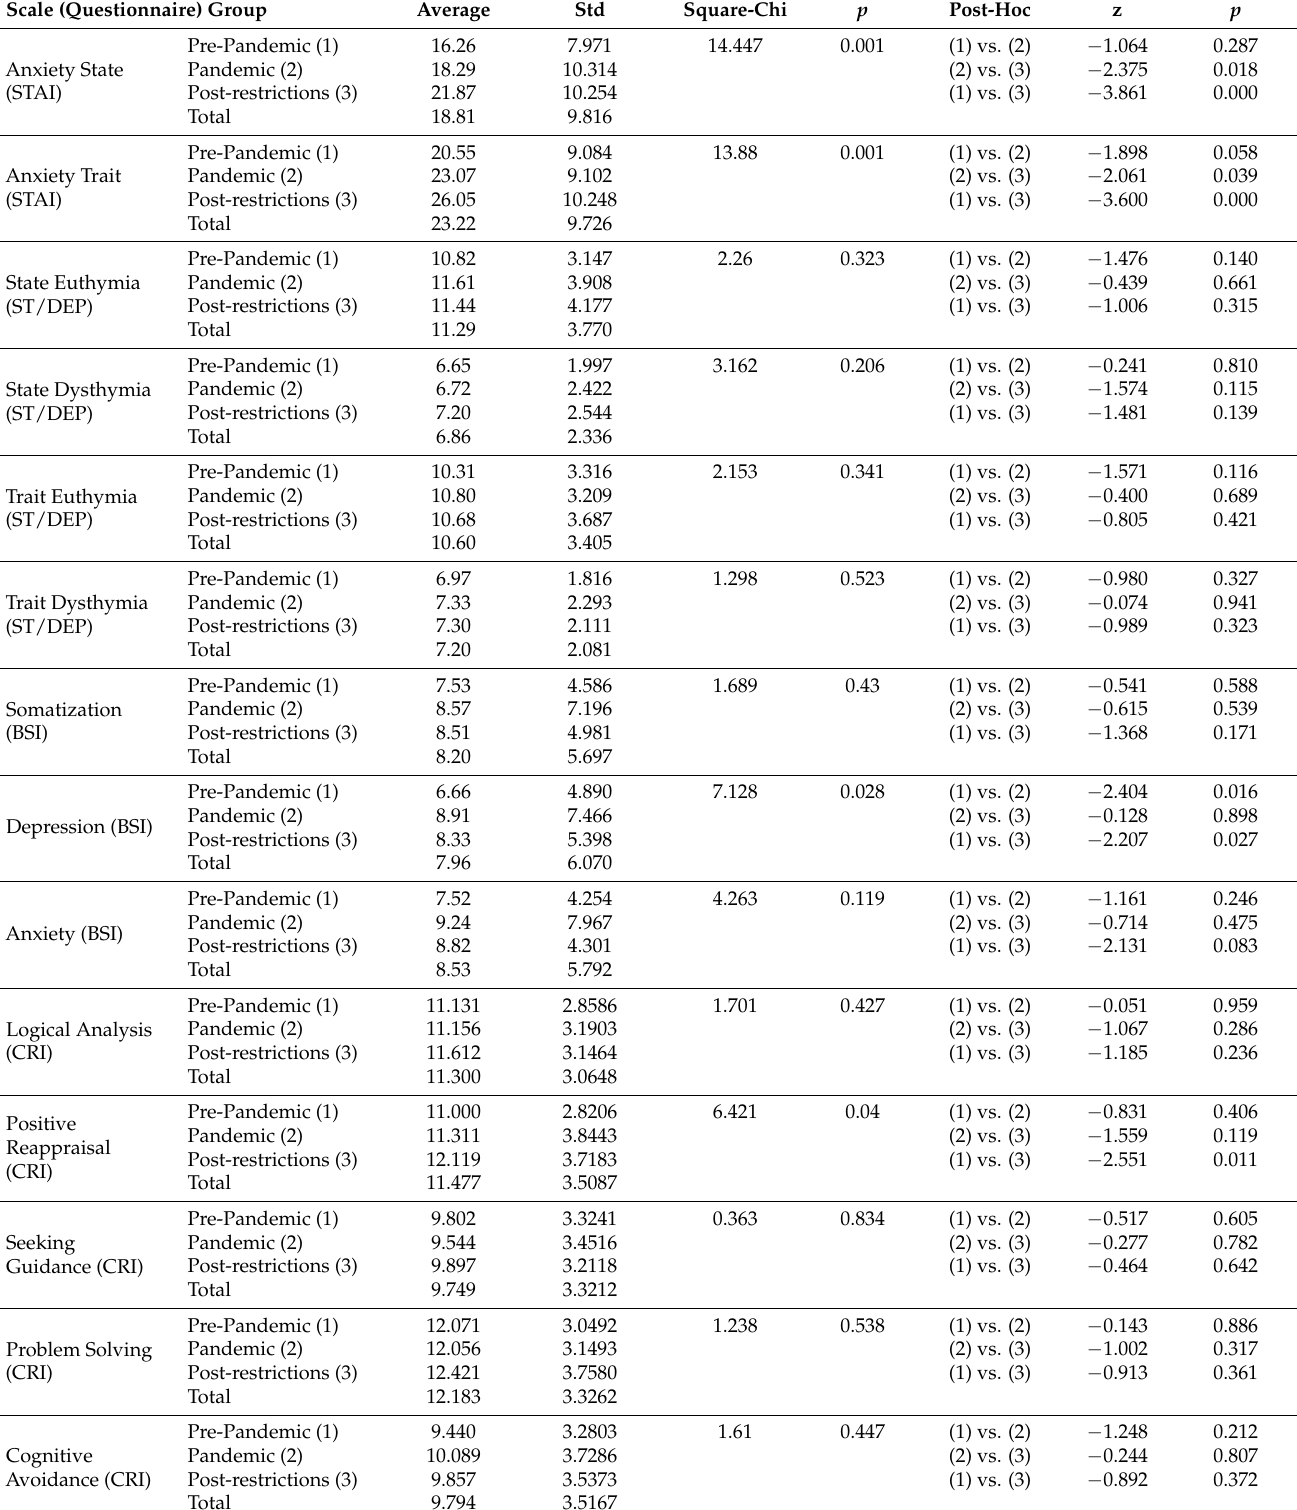
Table 1. Statistical results of the psychological scales. Data were analyzed by the Kruskal–Wallis χ 2 test. For further two-by-two comparisons, Mann–Whitney tests were